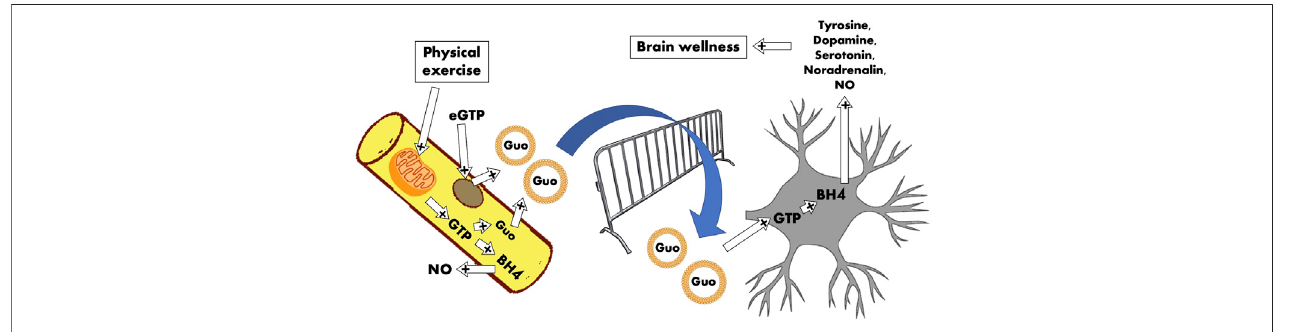
GRAPHICAL ABSTRACT | The cartoon represents the skeletal muscle compartment that releases guanosine exosomal-vehiculated regulators for the neuronal compartment. The idea is that the satellite cells (brown circle) and skeletal fi bers (yellow) are the continuous source of Guo-based molecules able to exert positive regulation on the central nervous system. The contraction, responsible for mitochondrial GTP production through GDP phosphorylation by means of succinyl-CoA synthetase, sustains GTP and in turn Guo disponibility and BH4 synthesis. Guo-stuffed exosomes are delivered to neurons that receive adequate amount of Guo- based molecules to transform into BH4 and in turn to several neurotransmitters (dopamine, serotonin, and